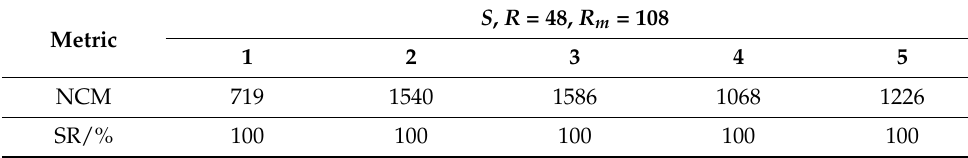
Table 2. The results of the parameter S